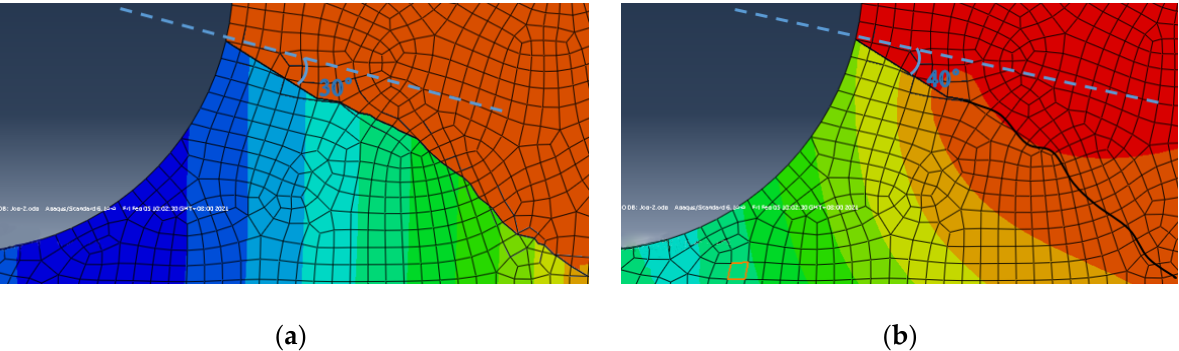
Figure 9. The crack propagation path under different initiation angles: ( a ) 30° initiation angle and ( b ) 40° initiation angle.